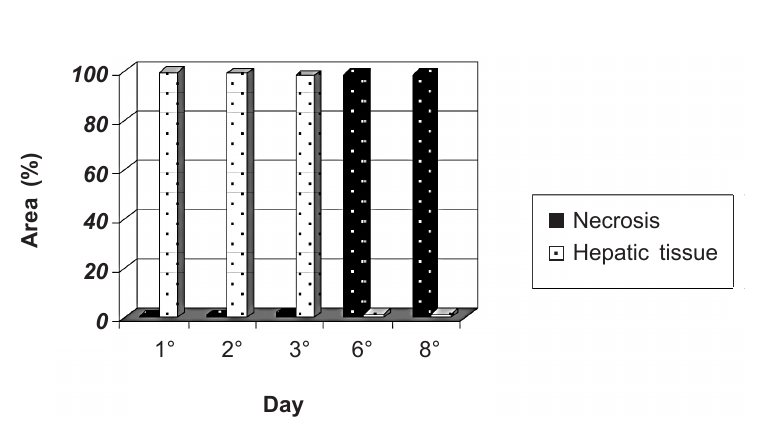
Fig. 4. – Number of E. dispar and E. histolytica trophozoites in hepatic necrosis in different per- iods of infection (n = 5 per group). No statistical difference was found between E. dispar and E. histolytica groups as measured by Kruskal- Wallis test (p >